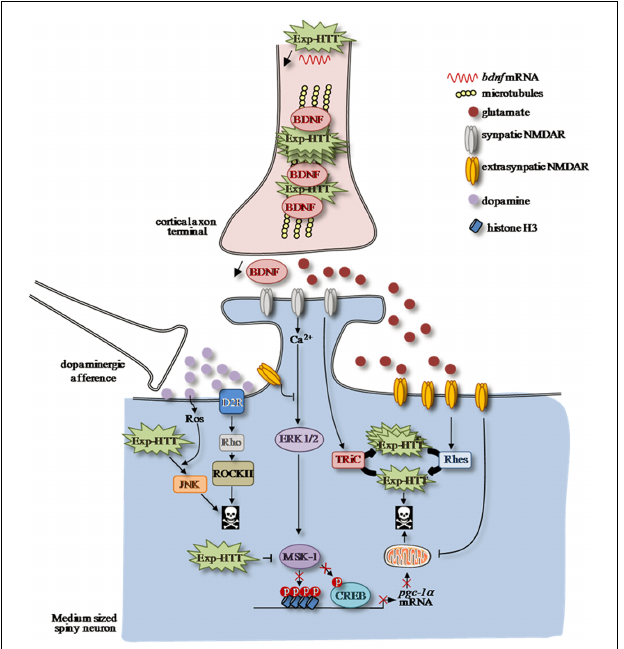
FIGURE 1 |Altered striatal signaling pathways in HD. Afferent corticostriatal and nigro-striatal projections modulate striatal signaling, which is impaired in Huntington’s Disease (HD). Neurotrophic factor BDNF release from cortical afferences is decreased in cortico-striatal synapses as a consequence of Exp-HTT-mediated down-regulation of bdnf transcription and axonal transport in cortical neurons. A shift from synaptic to extrasynaptic NMDAR-dependent signaling participates to striatal neurons to death. In a physiological condition, calcium influx through synaptic NMDAR promotes activation of the MAPkinase/ERK signaling pathway along with its nuclear target, the MSK-1 protein, which phosphorylates the transcription factor CREB. MSK-1 activation promotes chromatin remodeling, which is crucial for CREB-mediated pgc-1 α transcription, a key gene involved in mitochondria biogenesis. Synaptic NMDARs also promote formation of non-toxic Exp-HTT inclusion viaTRIC. In HD, localization and activity of extrasynaptic NMDAR are enhanced by Exp-HTT, which promotes neuronal cell injury and death.The toxic effect of extrasynaptic NMDAR is partly due to (i) the upregulation of Rhes expression that disaggregates the non-toxic Exp-HTT inclusions (ii) to an impairment of mitochondrial functions and (iii) to a decrease of the ERK/MSK-1/CREB signaling module to the pgc-1 α promoter. Dopamine release from nigro-striatal inputs promotes oxidative stress via the production of reactive oxygen species (ROS), which potentiates activation of the pro-apoptotic JNK pathway induced by Exp-HTT. In addition, Dopamine potentiates Exp-HTT-mediated striatal neurons death through activation of the Rho/ROCK signaling pathway downstream